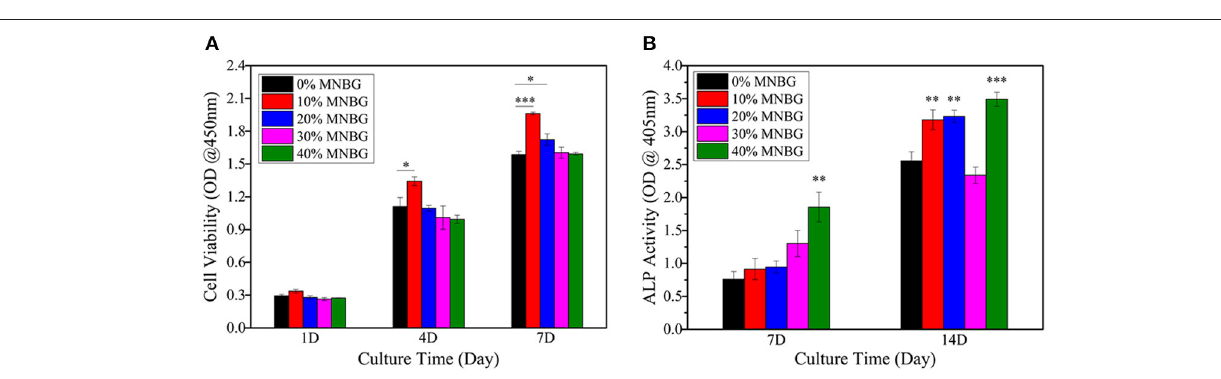
could survive well on the composite scaffold with MNBG,